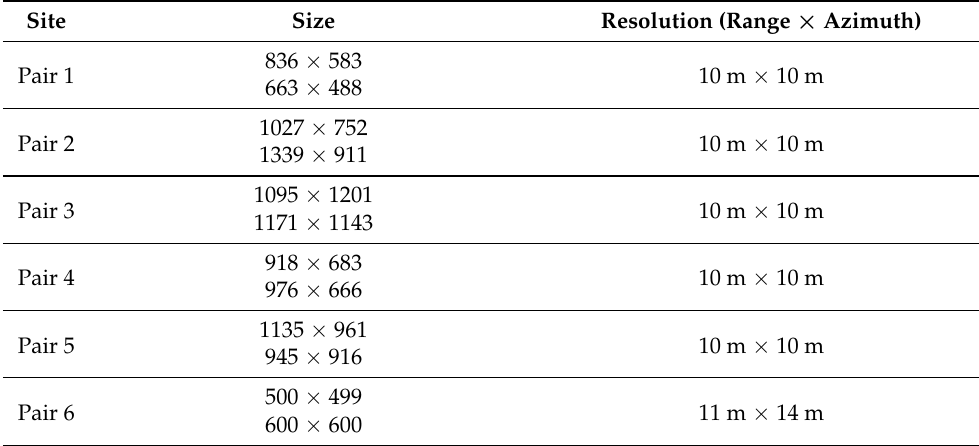
Figure 11. The training dataset of SAR images obtained by the Gaofen-3 system. ( a ) Desert. ( b ) Moun- tain. ( c ) Lake. ( d ) Urban. Table 2. Detailed Information about SAR image pairs used for